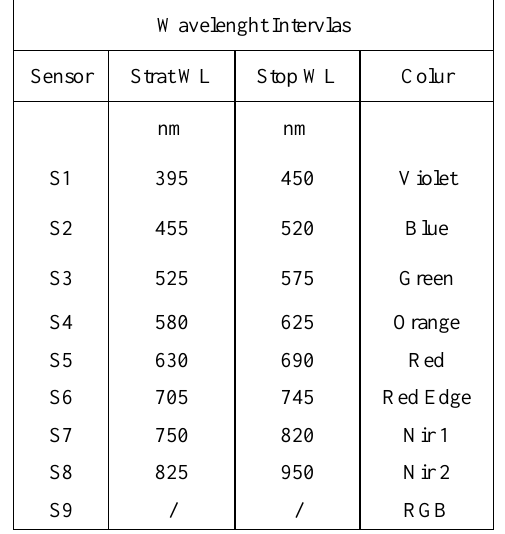
Table 1. Wavelenght intervals of MAIA WV-2 bands